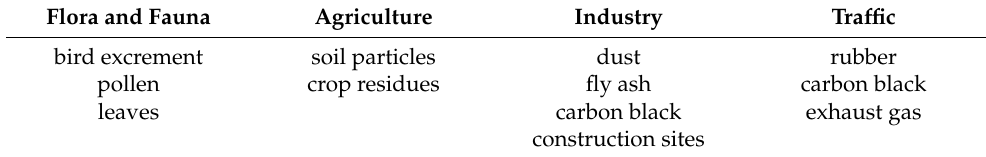
Table 1. The most commonly occurring contamination from the environment of the solar system. Flora and Fauna